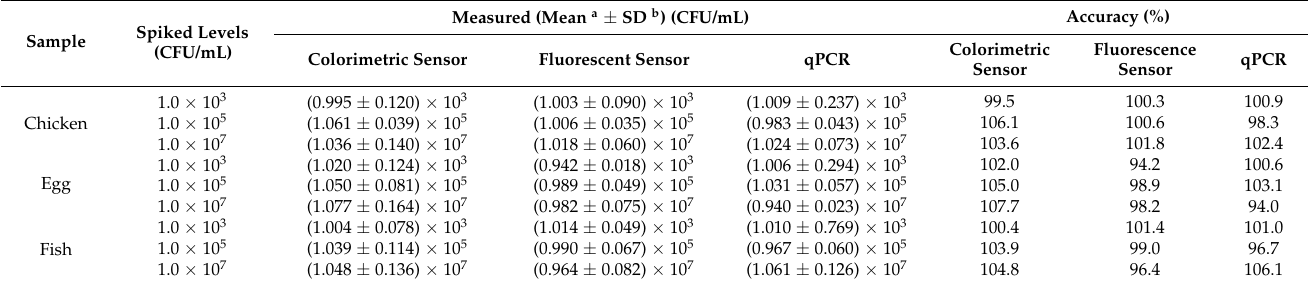
Table 2. Determination of Salmonella in real food using the developed UCNPs-MB PCR biosensor.